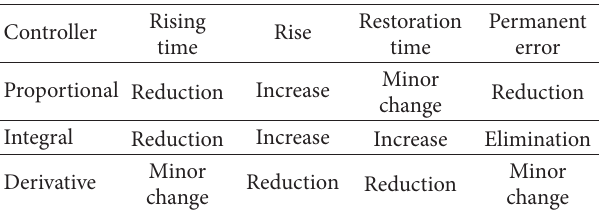
Table 1: Effect of controllers in the